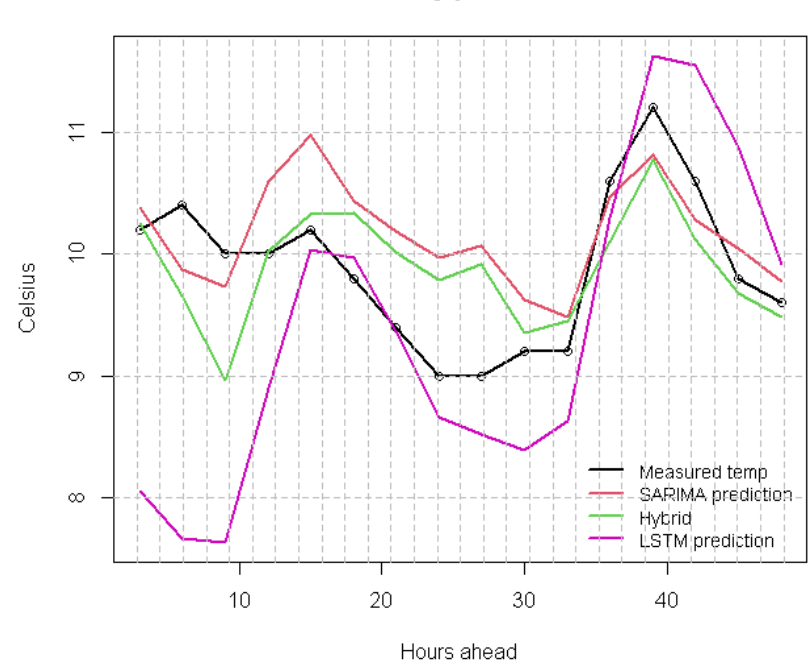
Figure 4. Comparison of SARIMA, LSTM and hybrid with real data on temperature example for 2- 2-day prediction horizon in day prediction horizon in January.